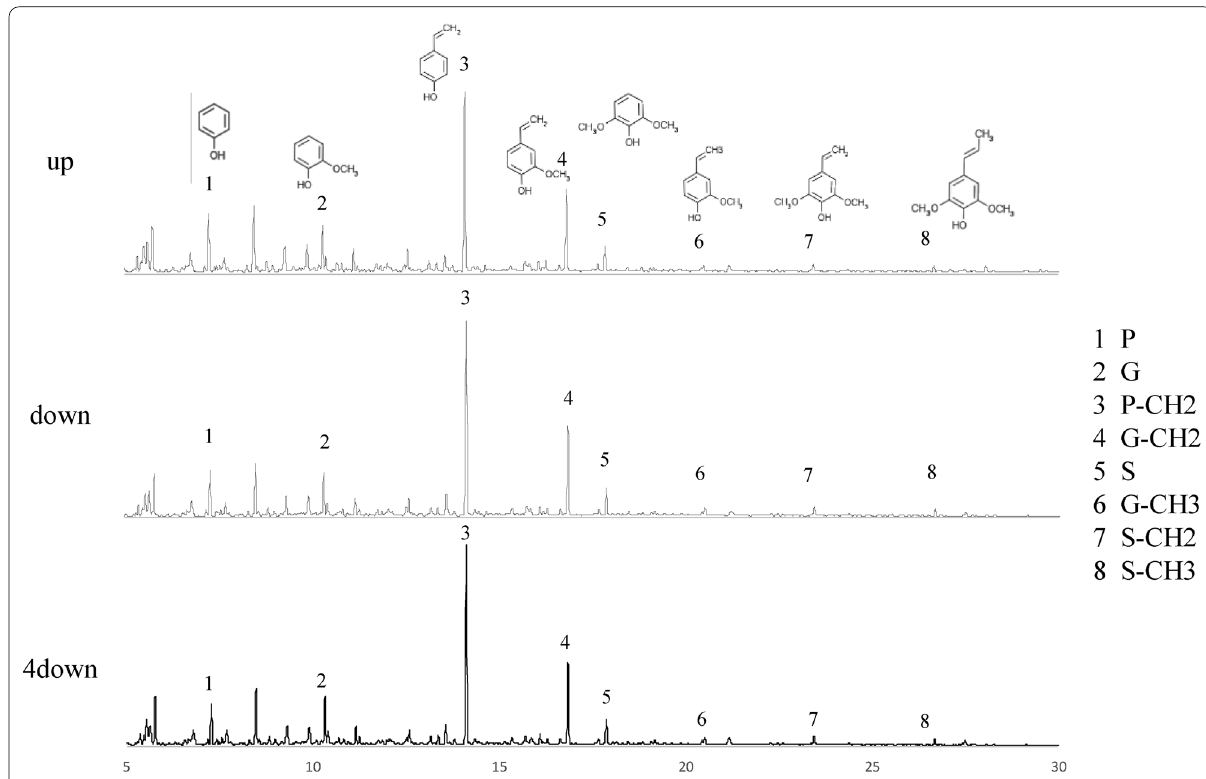
Fig. 3 Results of the Py-GC analysis of the “Uradome” upper and lower